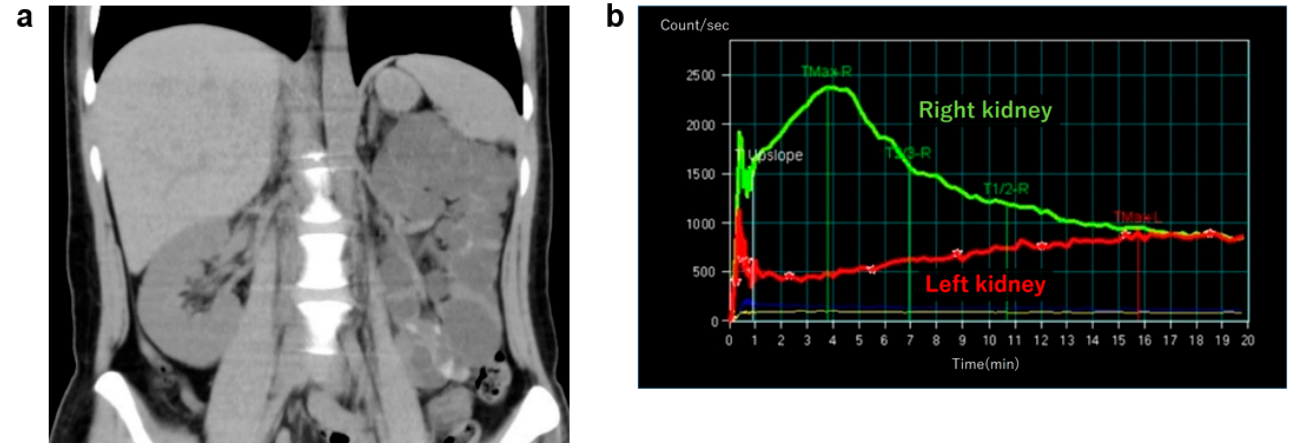
Figure 4. Multicystic kidney/multicystic dysplastic kidney (MCDK): 30s, female, no family history of polycystic kidney disease or end-stage kidney disease, hepatic lesions, cerebral aneurysm, or heart valve disease, kidney function eGFR 70.2 mL/min/1.73 m 2 (images provided by Kurume University). ( a ) Non-contrast CT image (coronal section), unilateral (left side) several renal cysts were observed. Cyst’s density varied from low to high absorption. High density in hemorrhagic cysts, isodense areas suggest obsolete hemorrhage. Kidney volume was 222 mL for the right kidney, and 692 mL for the left kidney. ( b ) Renal dynamic scintigraphy: blood flow phase/functional phase/excretion phase of the right kidney (green line) remain good, indicating normal function. The 3 phases of the left kidney (red line) are deteriorating, indicating